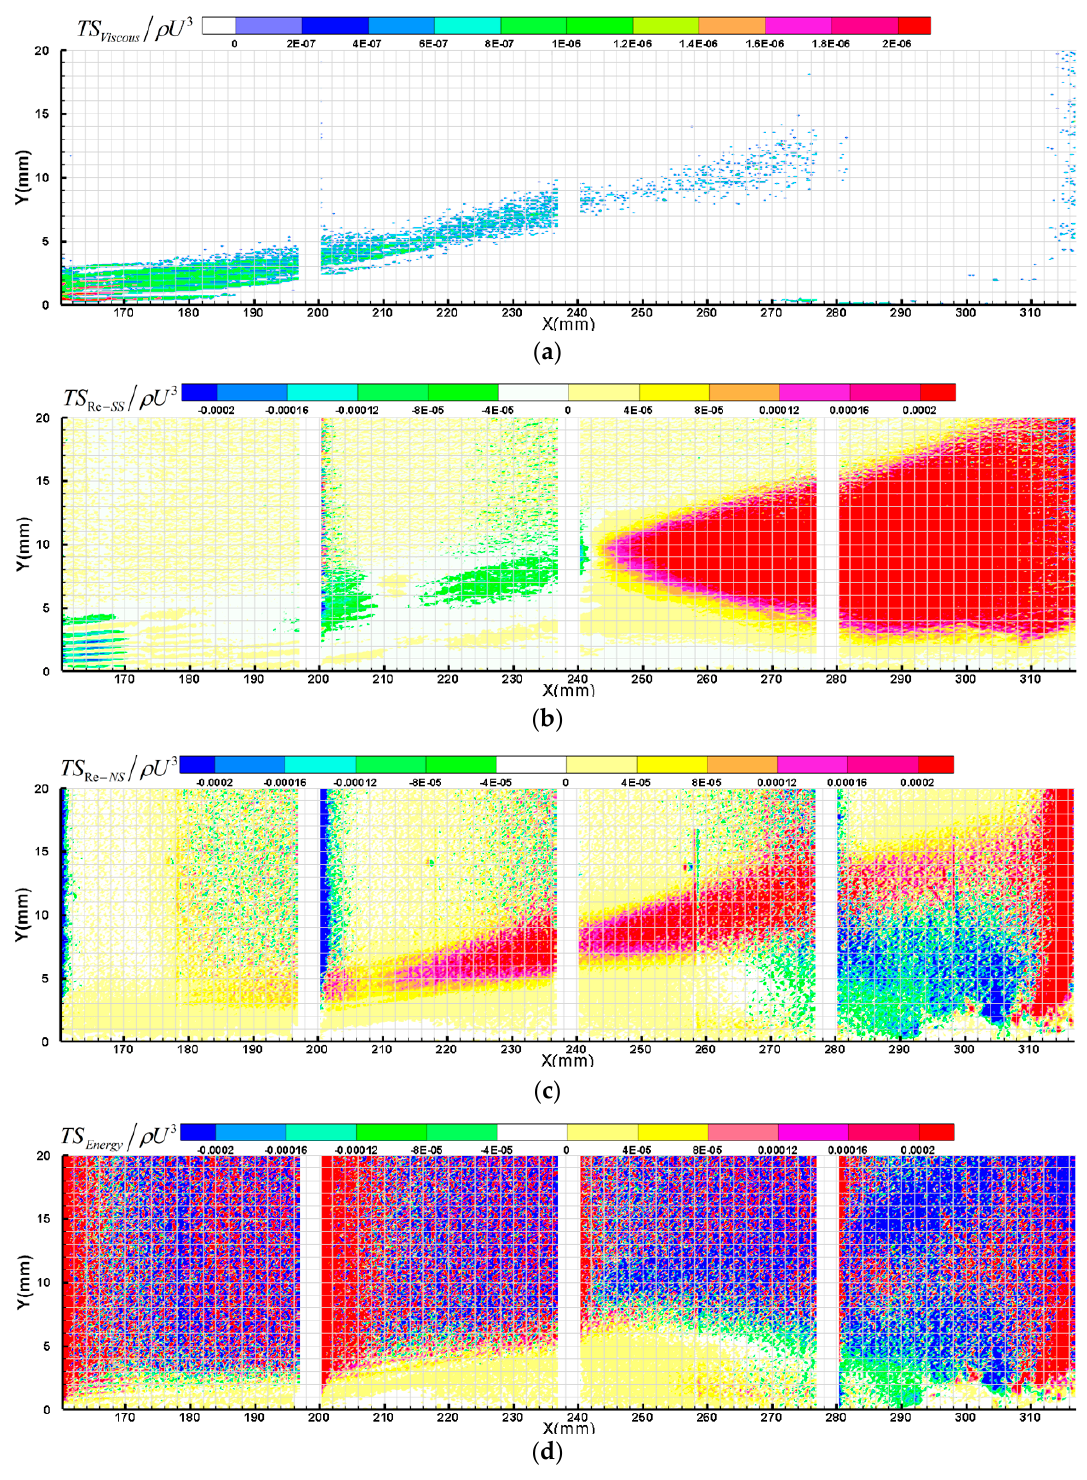
Figure 11. Distribution of different terms of entropy generation: ( a ) the mean viscous dissipation term; ( b ) the Reynolds sheer stress term; ( c ) the Reynolds normal stress term; and ( d ) the energy flux term.